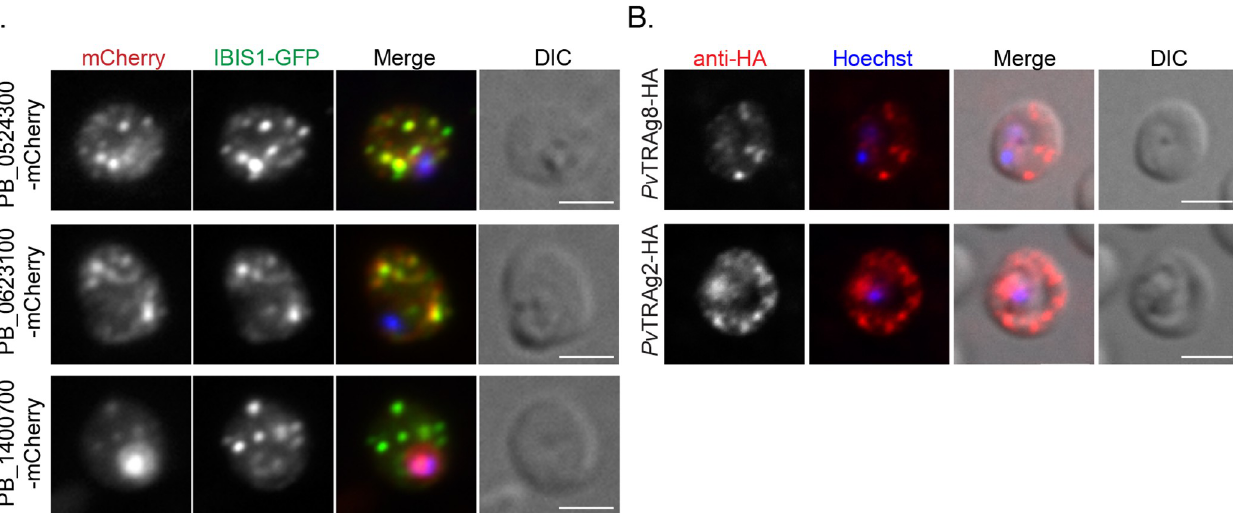
Fig 3. PBANKA_0524300 (IPIS2), PBANKA_0623100 (IPIS3), PBANKA_1400700 and putative P . vivax orthologs localize to discrete structures in the cytoplasm of infected erythrocytes. A) PBANKA_0524300-mCherry, PBANKA_0623100-mCherry, and PBANKA_1400700-mCherry colocalize with the IBIS marker IBIS1-GFP in the erythrocyte cytoplasm. Infected cells were fixed and labeled with anti-GFP and anti-mCherry antibodies to amplify the fluorescent signal. Scale bars, 5 μ m. B) Erythrocytes infected with P . berghei expressing the HA-tagged P . vivax proteins Pv TRAg8 or Pv TRAg2, which are putative orthologs of IPIS2 and IPIS3, respectively, were fixed and labeled with anti-HA antibodies. Scale bars, 5 μ m.